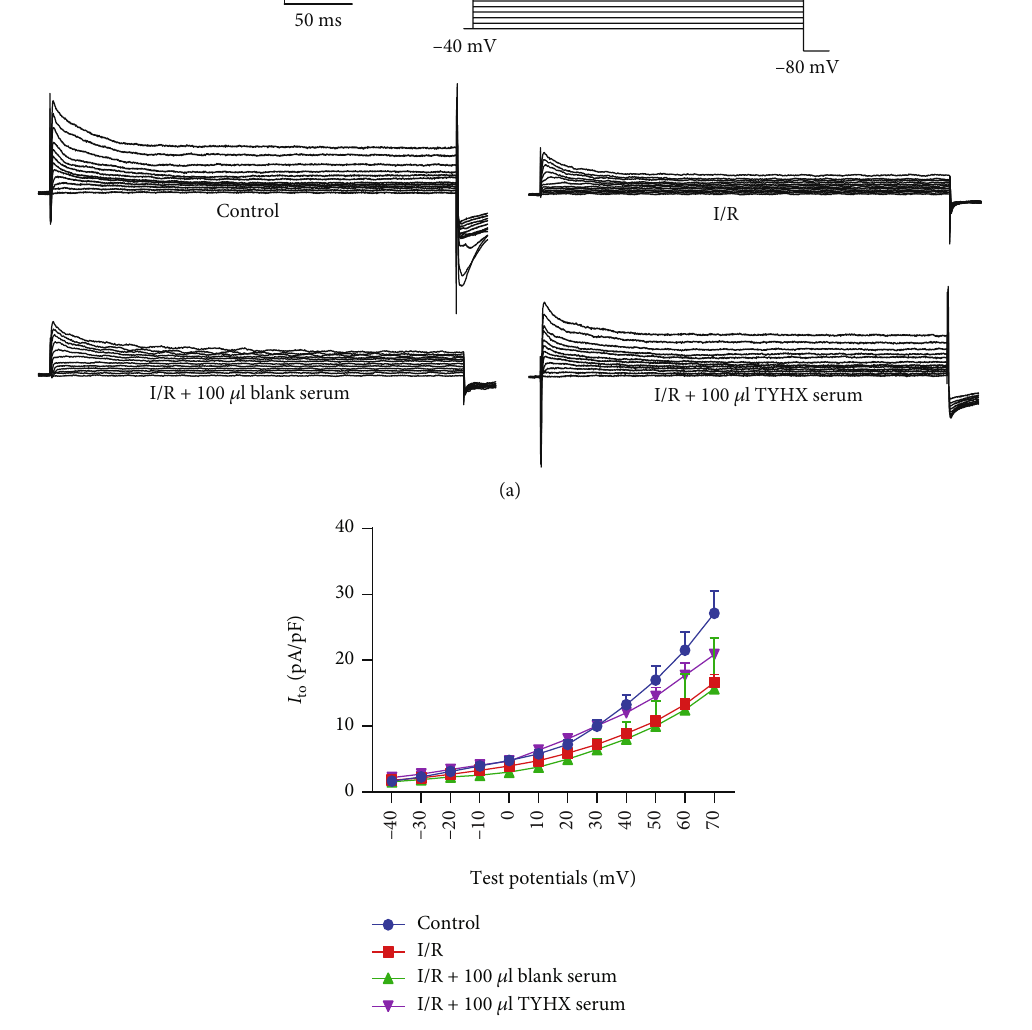
. (a) Current traces of I to